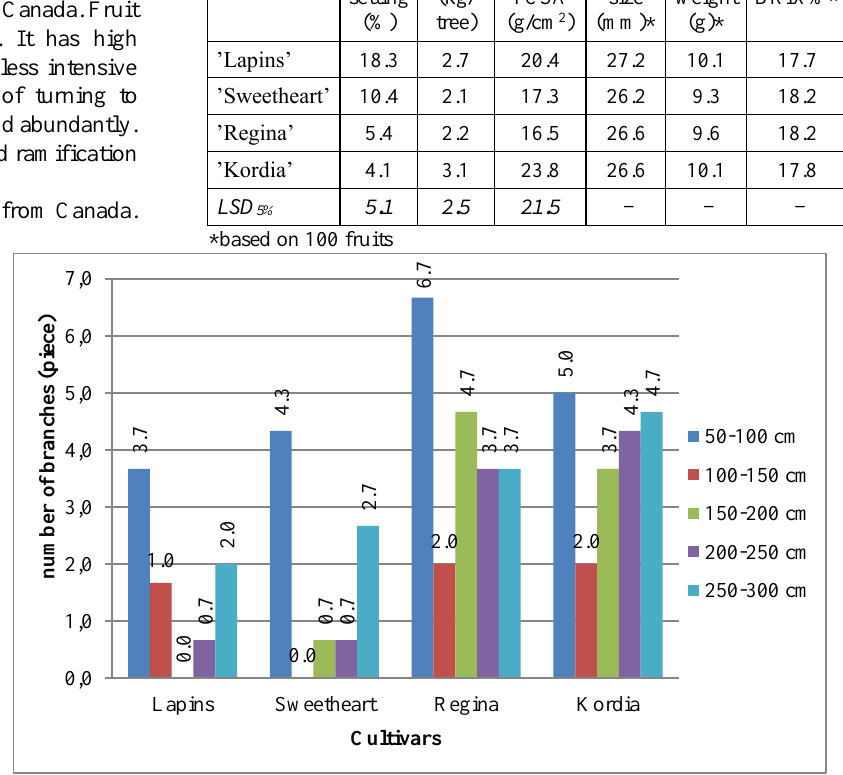
Figure 1. Number of the branches emerging from the central axis in different height